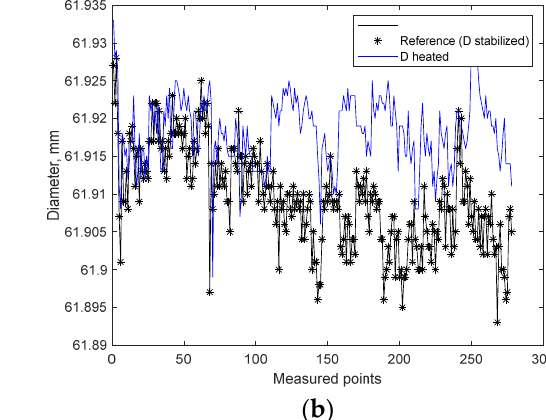
Figure 4. Diameter measurement value at point A on the workpiece for the first fifty workpieces (50 measured points) with process corrections marked.